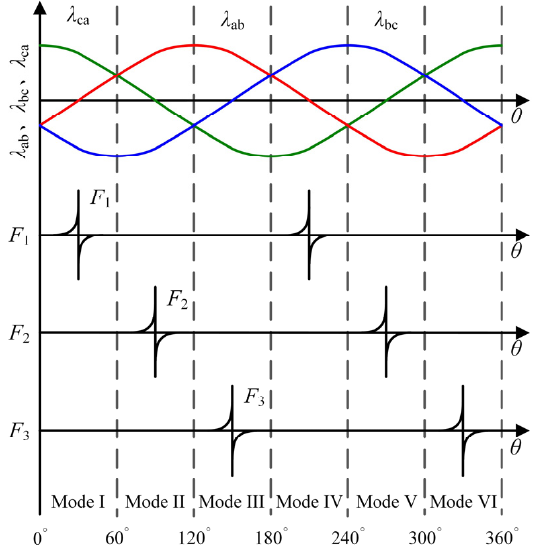
Figure 4. Line-to-line PM flux linkage and function F 1 , F 2 , F 3 diagram.